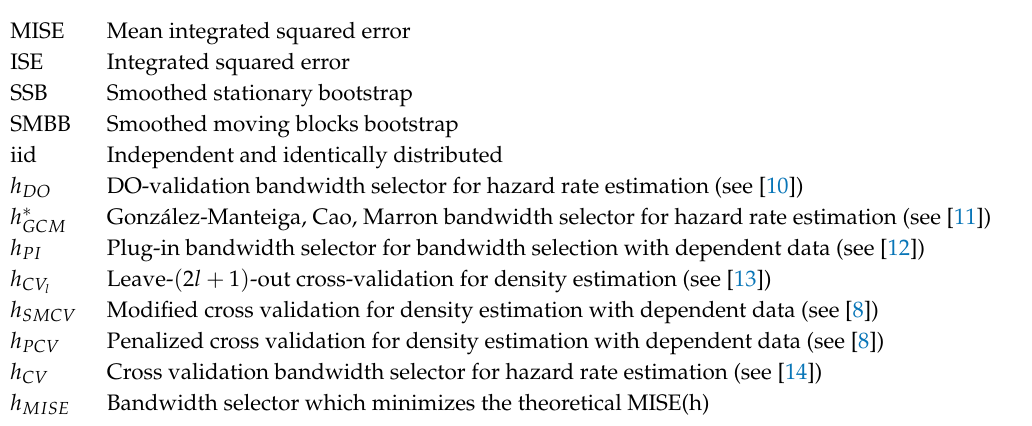
Table 1. Mean and median of ISE ( ˆ h ) , n = 100, where ˆ h = h CV (third column), h DO (fourth column), h BOOT 1 (fifth column), h BOOT 2 (sixth column) and h ∗